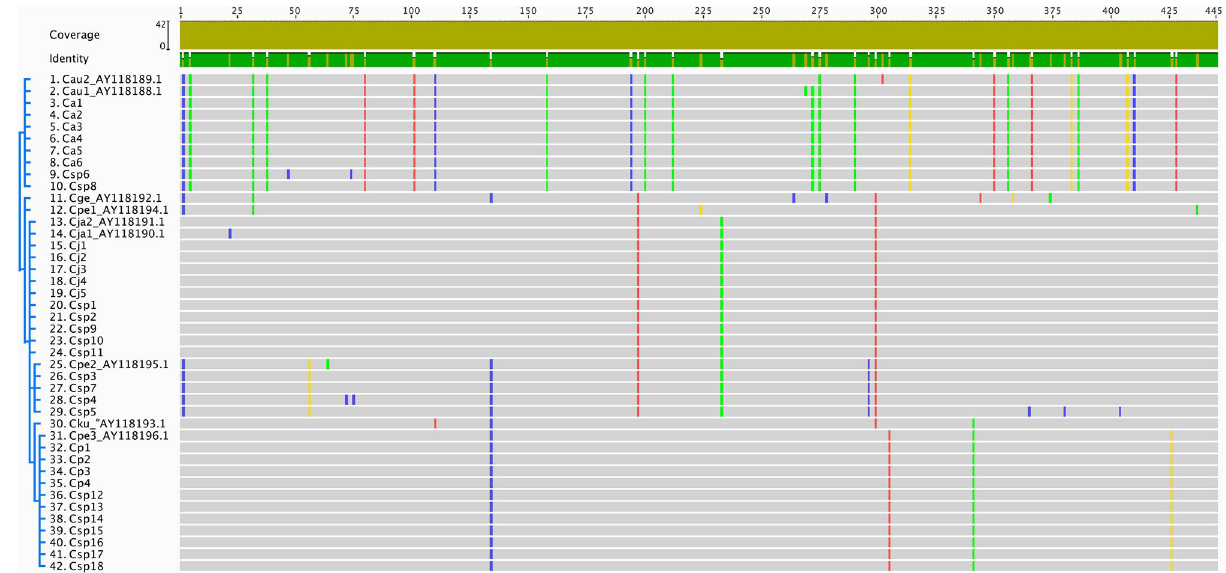
Figure 4. Alignment of the DNA sequencing of 445 base pairs of the cytochrome c oxidase subunit II ( COX2 ) gene. One haplotype was detected for Callithrix aurita ( Ca ), one for C. jacchus ( Cj ), one for C. geoffroyi, one for C. kuhlii and three for C. penicillata ( Cp ). The 18 sequences from the Callitrix sp. ( Csp ) free-living individuals aligned with Ca , Cj , and two Cp haplotypes. The gray color represents similarities among the nucleotide sequences of all individuals. The blue colored bar represents cytosine in that position, yellow for guanine, green for thymine and red for adenine. The sequences identified by AY were obtained from GenBank®.